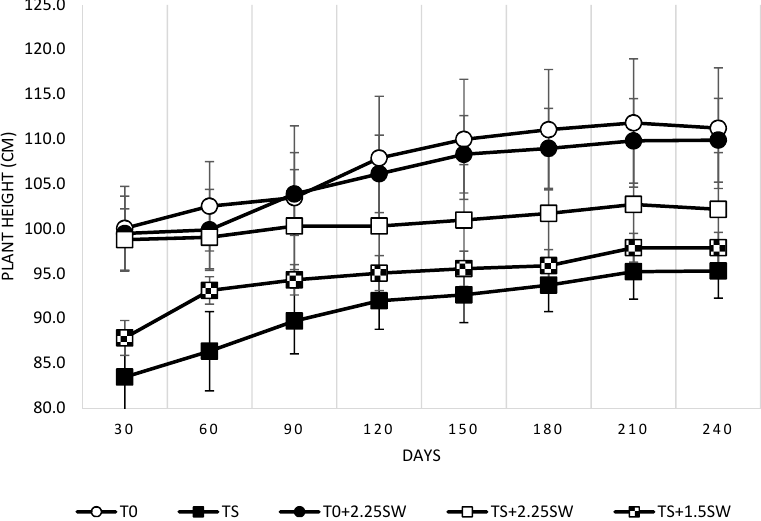
Figure 1. Changes in plant height in 2 year old Hass avocado plants grown in pot subjected to different treatments (T0: distilled water, TS: saline water (9 mM NaCl), T0 + 2.25SW: distilled water + 2.25 mL seaweed, TS + 2.25SW: saline water (9 mM NaCl) + 2.25 mL seaweed T0 + 1.5 mL seaweed), measurements were made every 30 days until completion at 240 days of study, with 6 replicates per treatment. Table 1. Growth parameters and leaf necrosis percentage at the end of the study period (240 days) of 2 year old Hass avocado plants grown in pot under different treatments (T0: distilled water, TS: saline water (9 mM NaCl), T0 + 2.25SW: distilled water + 2.25 mL seaweed, TS + 2.25SW: saline water (9